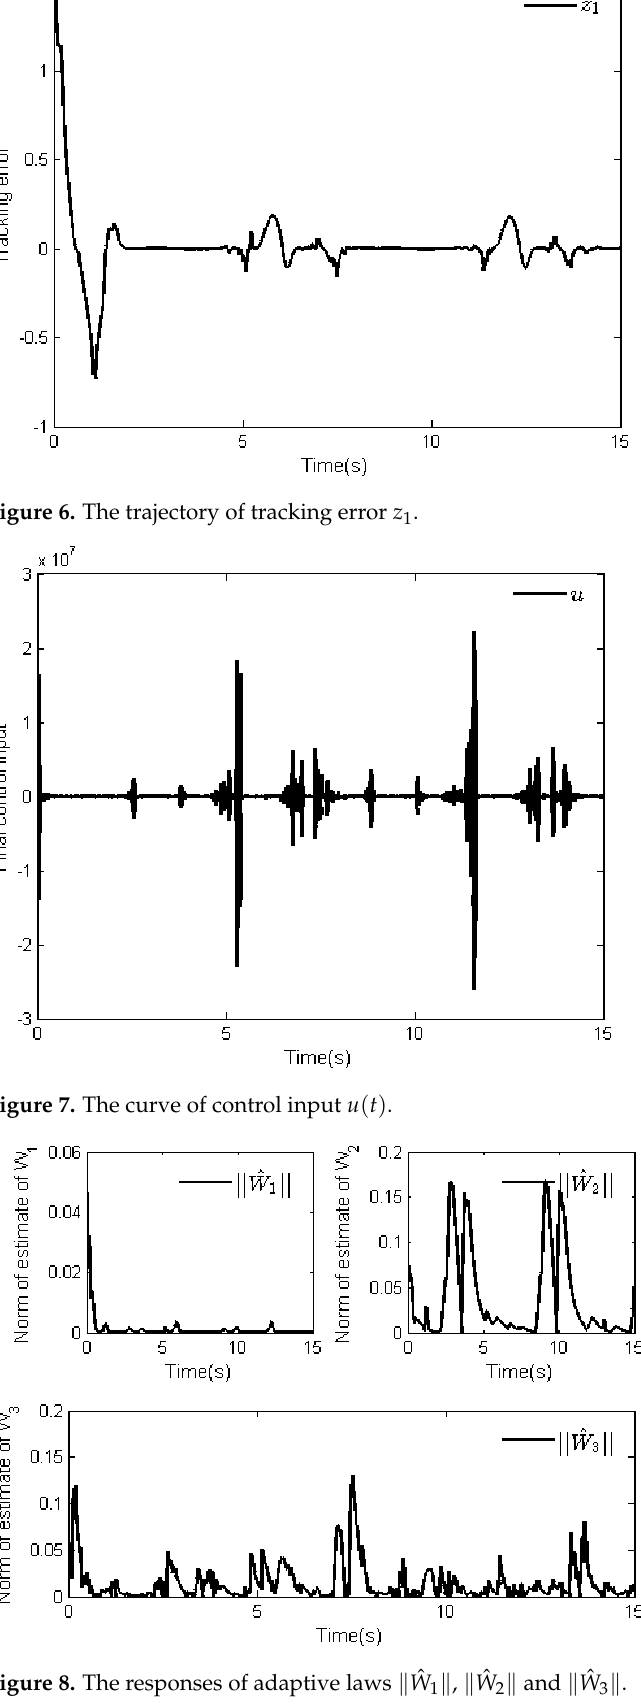
Figure 8. The responses of adaptive laws